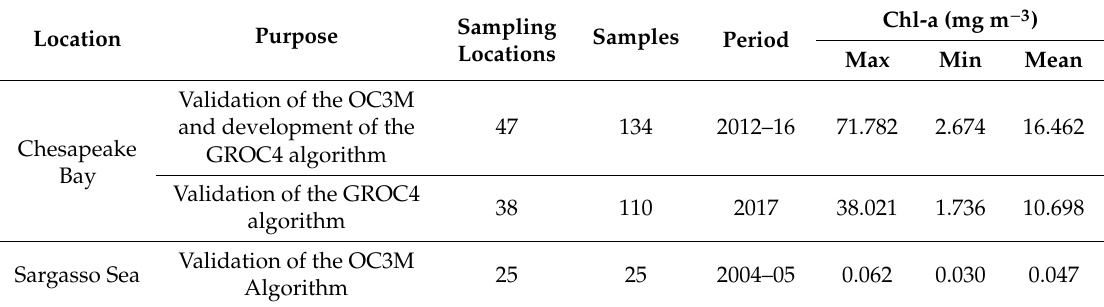
Figure 2. Map showing the locations of Chl-a in situ measurements used in our study. ( a ) Monitoring stations used for the validation of the Ocean Color 3M (OC3M) algorithm in Chesapeake Bay, and development of the GROC4 algorithm and ( b ) Sampling locations in the Sargasso Sea, Atlantic Ocean. Table 1. Summary of in situ Chl-a data used in this study.